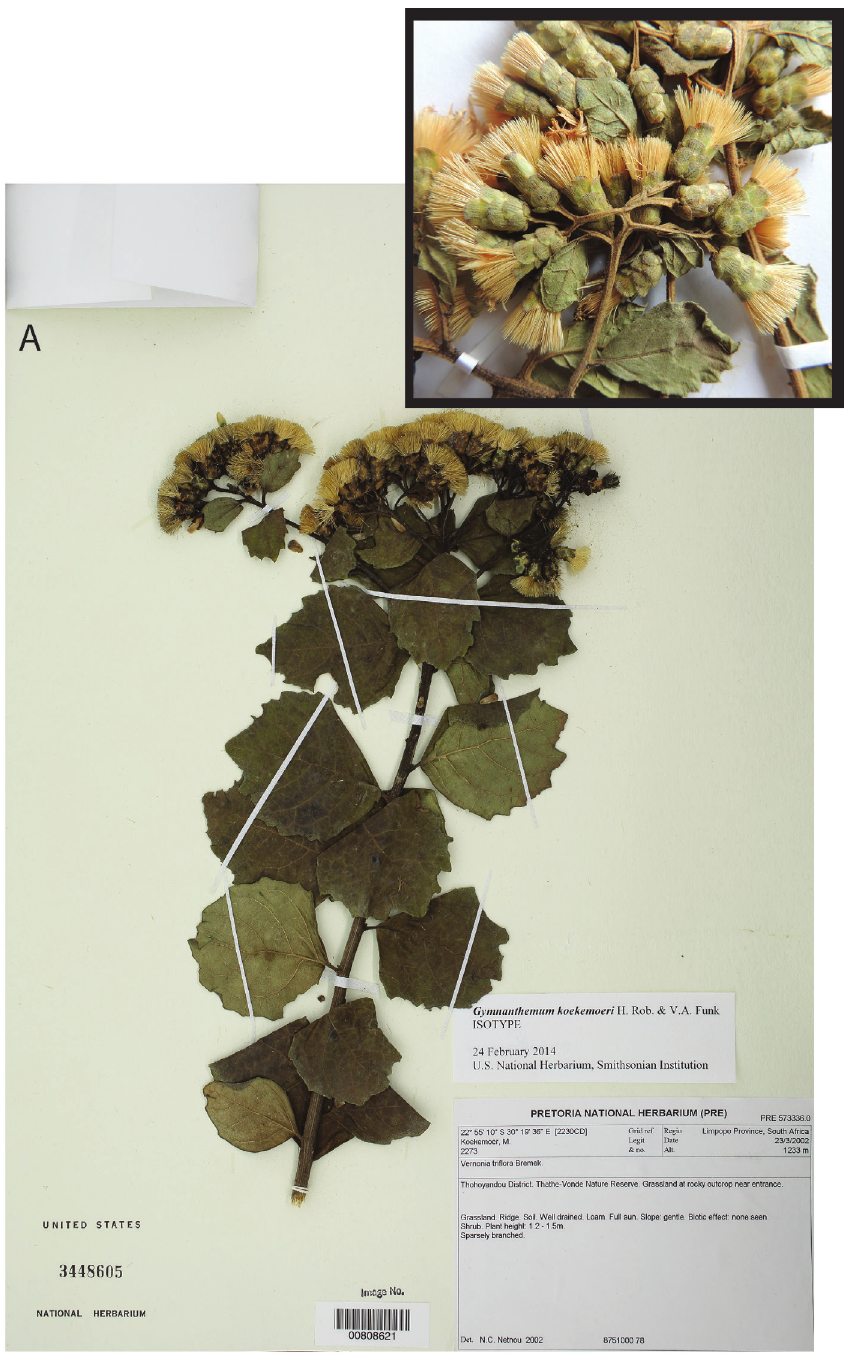
Figure 1. Type specimens. A Photograph of the isotype (US) B Photograph of the inflorescence of the holotype